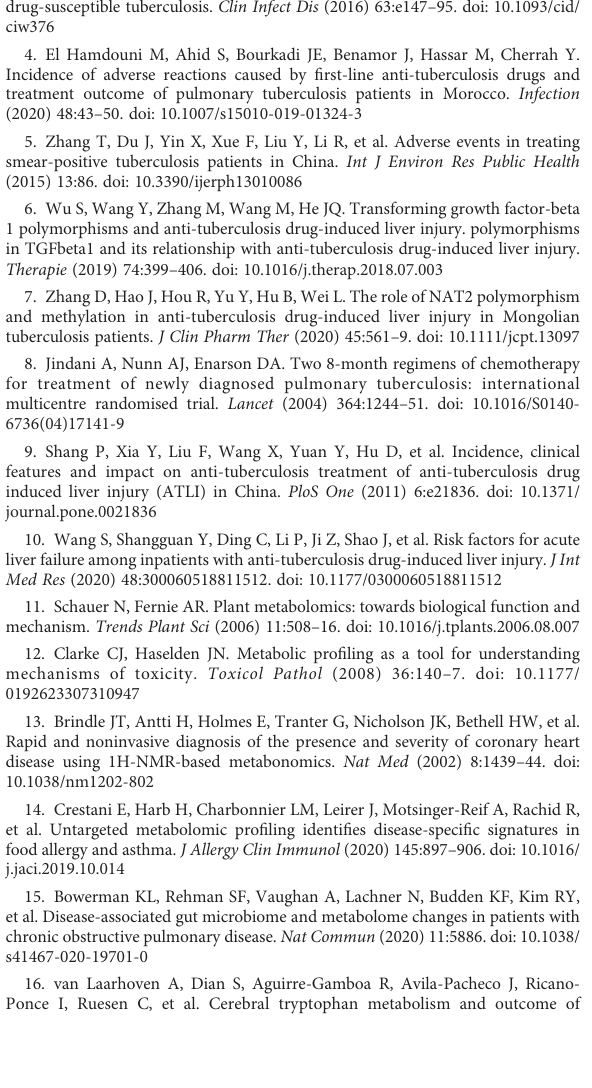
SUPPLEMENTARY FIGURE 2 Volcano map of differential metabolites in subgroup analysis.